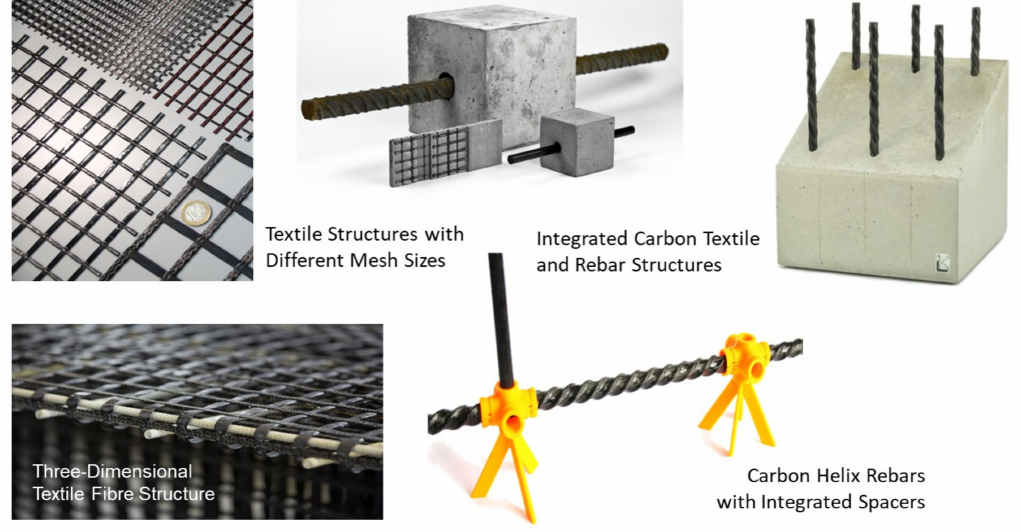
Figure 2. Novel carbon fibre reinforcement systems: textile preforms and bar-shaped